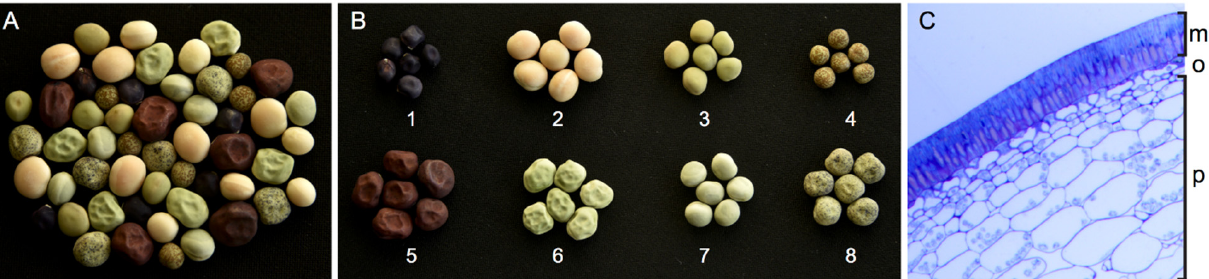
Figure 1. Seed coat diversity and structure in Pisum sativum L. ( A ) Selected dry pea seeds at maturity illustrate the breadth of seed coat color, size, and texture phenotypes that are attributed to the seeds. ( B ) Seed coat enriched in proanthocyanidins appear purple (1-22770A) and red (5-No. 3257). Seeds lacking proanthocyanidins appear yellow (2-CDC Amarillo). The color of the seed coat can be homogeneous (1-22770A, 3-PLP 174, 5-No. 3257, and 6-Kairyo Aotenashi), variegated (4-PLP 70 and 7-Uladovskij 208) or speckled (8-Biselia). ( C ) Cross-section of the pea seed (2-CDC Amarillo) revealing layers of a maturing seed coat. Layers visible here include an outermost epidermis of macrosclereids (m), a subepidemis of osteosclereids (o), and underlying seed coat parenchyma (p), with the chlorenchyma sub-layer visible.